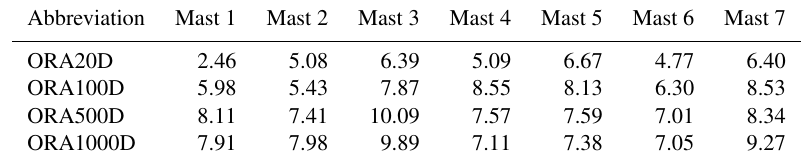
Table 4. Displacement height (m) determined from pixels within a 50m radius around each mast location for each of the ORA maps.